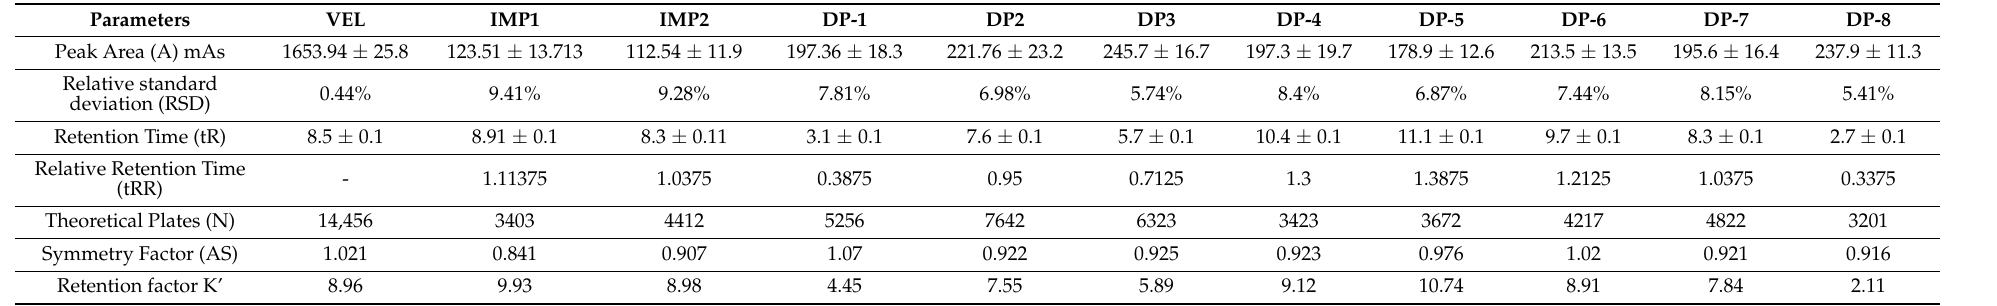
Table 1. System suitability studies.